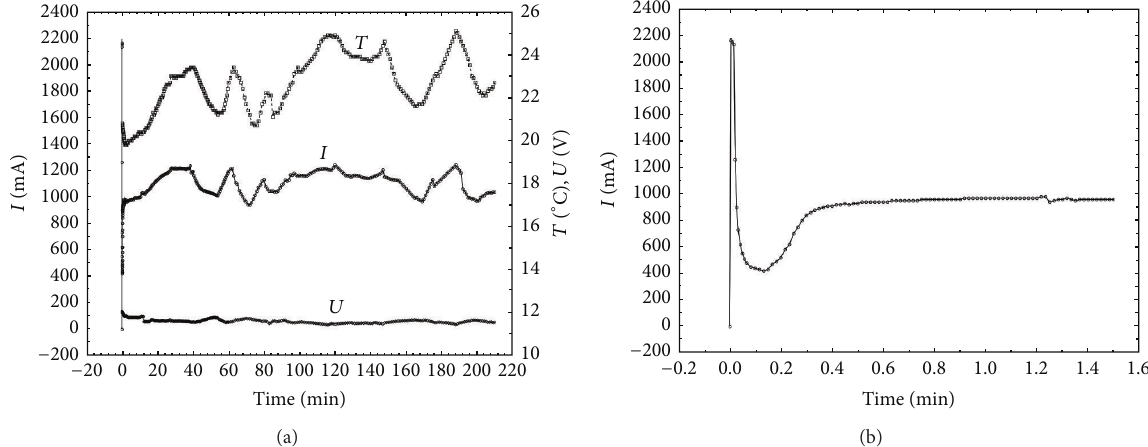
Figure 2: The time course of the voltage, current, and temperature during the anodic oxidation in sulfuric acid and oxalic acid at the temperature of 12 ∘ C, the voltage of 12 V: (a) t = 210 min, (b) t = 1.5